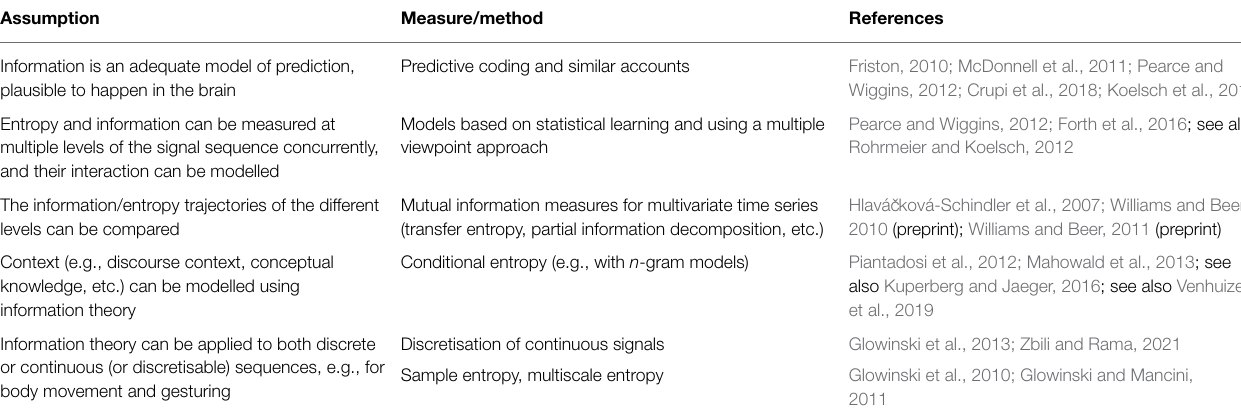
TABLE 3 | Assumptions and measures of information